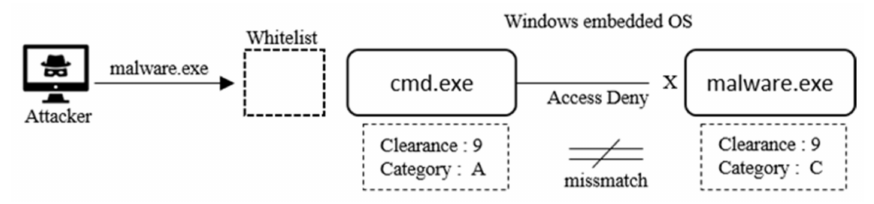
Figure 15. MAC-based whitelist security